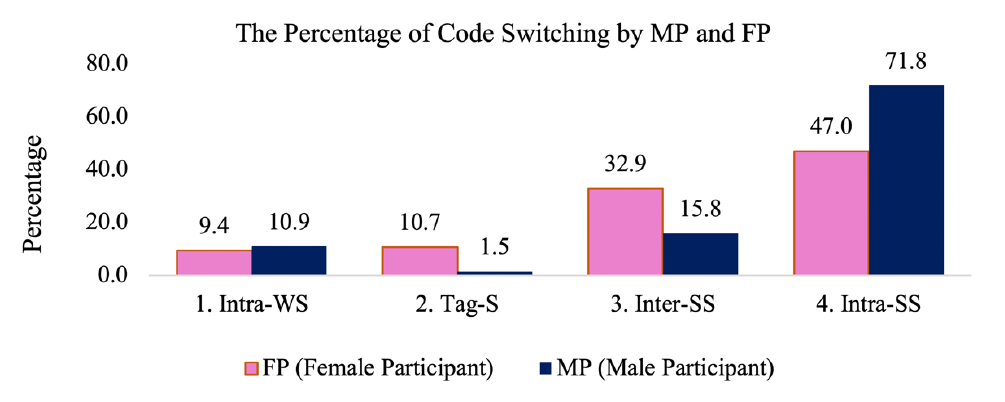
Figure 1. The percentage of Code-Switching type by MP and